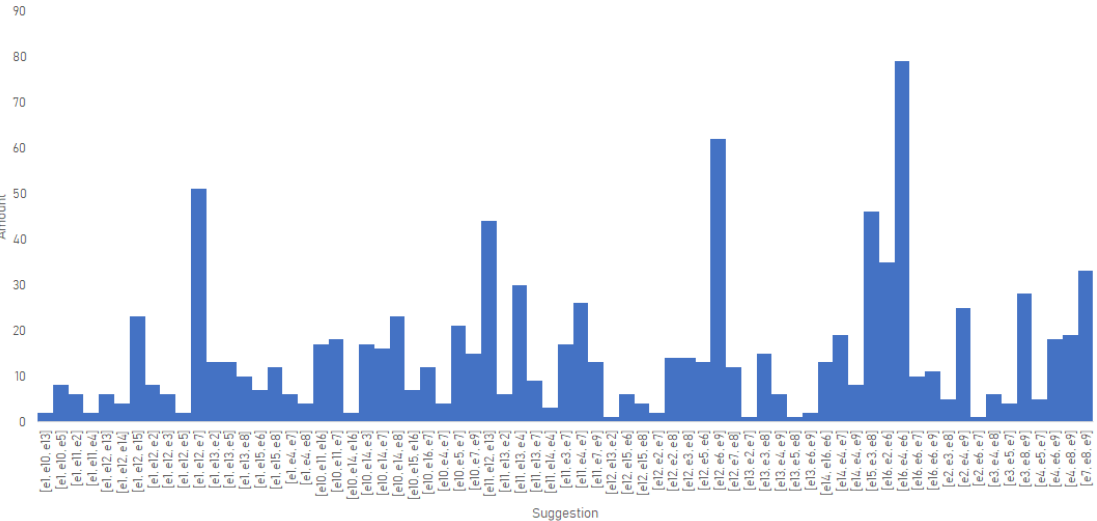
Figure 8. Distribution of a set of three exercises per suggestion using the new algorithm applied to the problematic